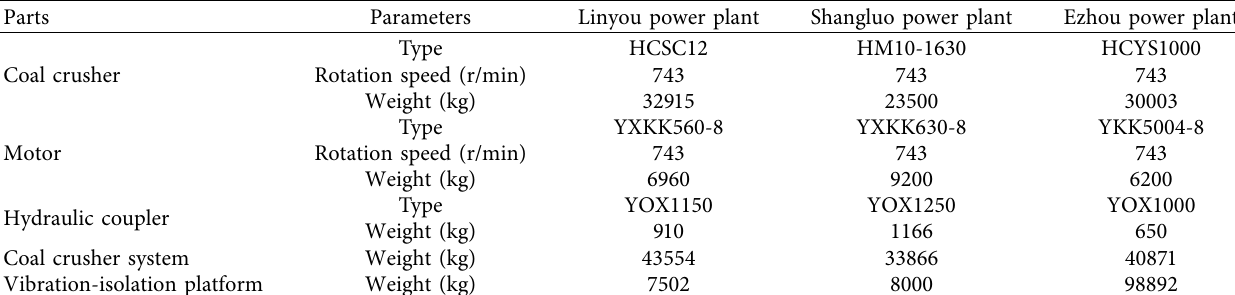
Table 1: Technical parameters of coal crusher systems and vibration-isolation platforms.